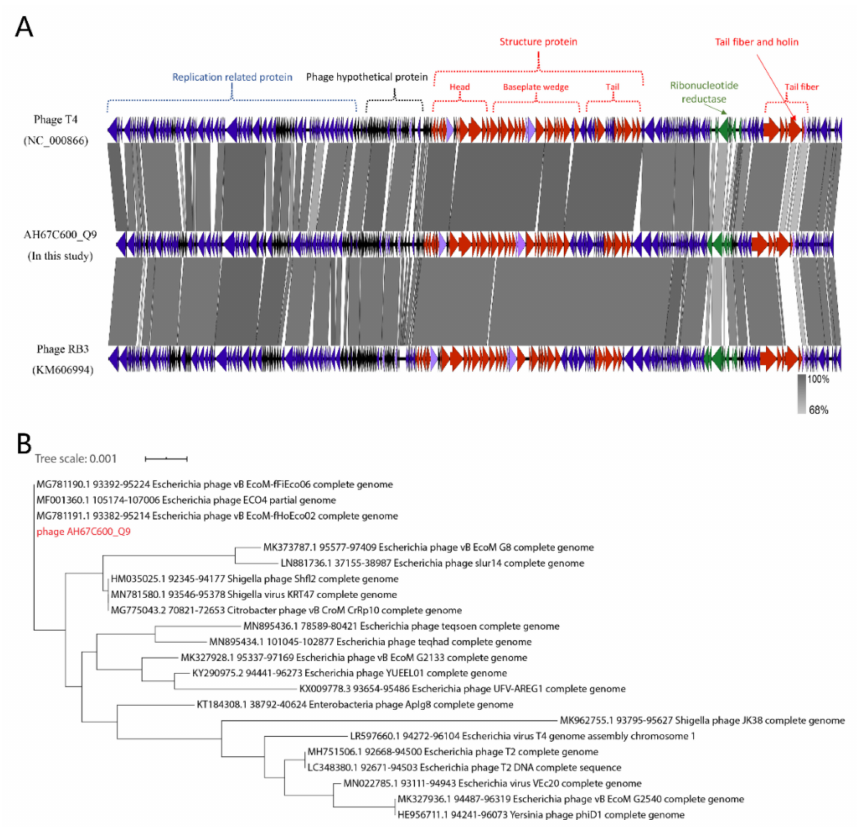
Figure 5. ( A ) Genome sequence alignment of phage AH67C600_Q9, T4 and RB3. The functional modules are indicated by color and similarities are shown in gray, according to the scale on the bottom right corner. ( B ) Phylogenetic analysis based on the large subunit of terminase for Enterobacteriaceae phage, demonstrating an independent branch for phage